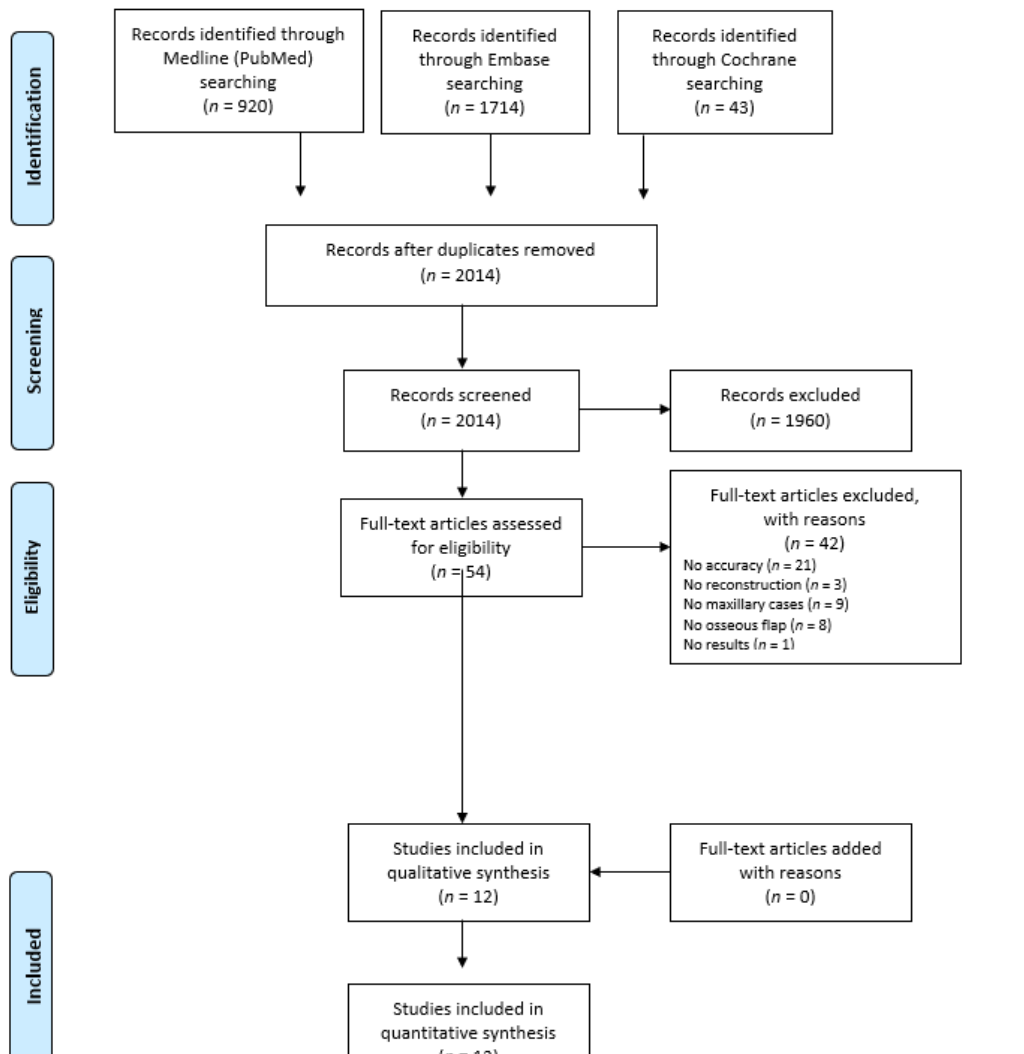
Figure 1. Flowchart methodology for the study selection process.